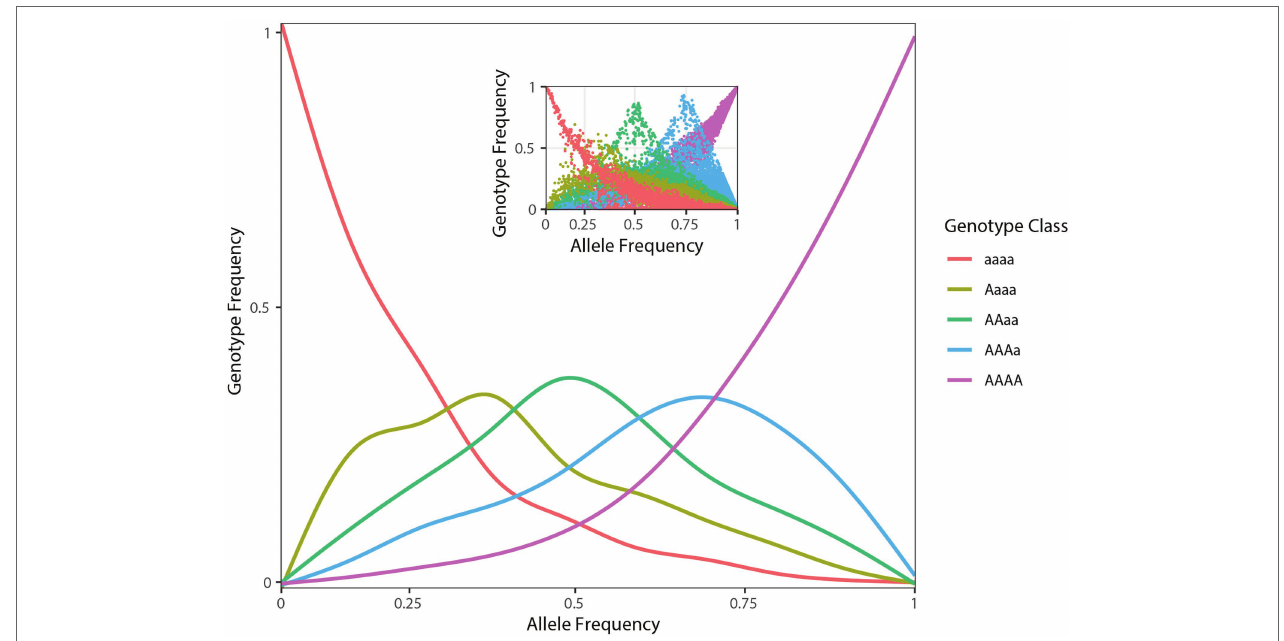
FIGURE 2 | Population genomic data consistent with tetrasomic inheritance. Genotype frequencies ( y -axis) as function of allele frequencies ( x -axis) in A. tinctoria. The inset shows raw plotting of genotype and allele frequencies of A. tinctoria. The estimates are derived from 16,107 SNPs present across all individuals. For tetrasomic inheritance, all five genotypes are expected to be observe at intermediate (0.5) allele frequency. In addition, the three middle peaks are expected to be of similar height. The pattern observed here is largely consistent with tetrasomic inheritance (see section